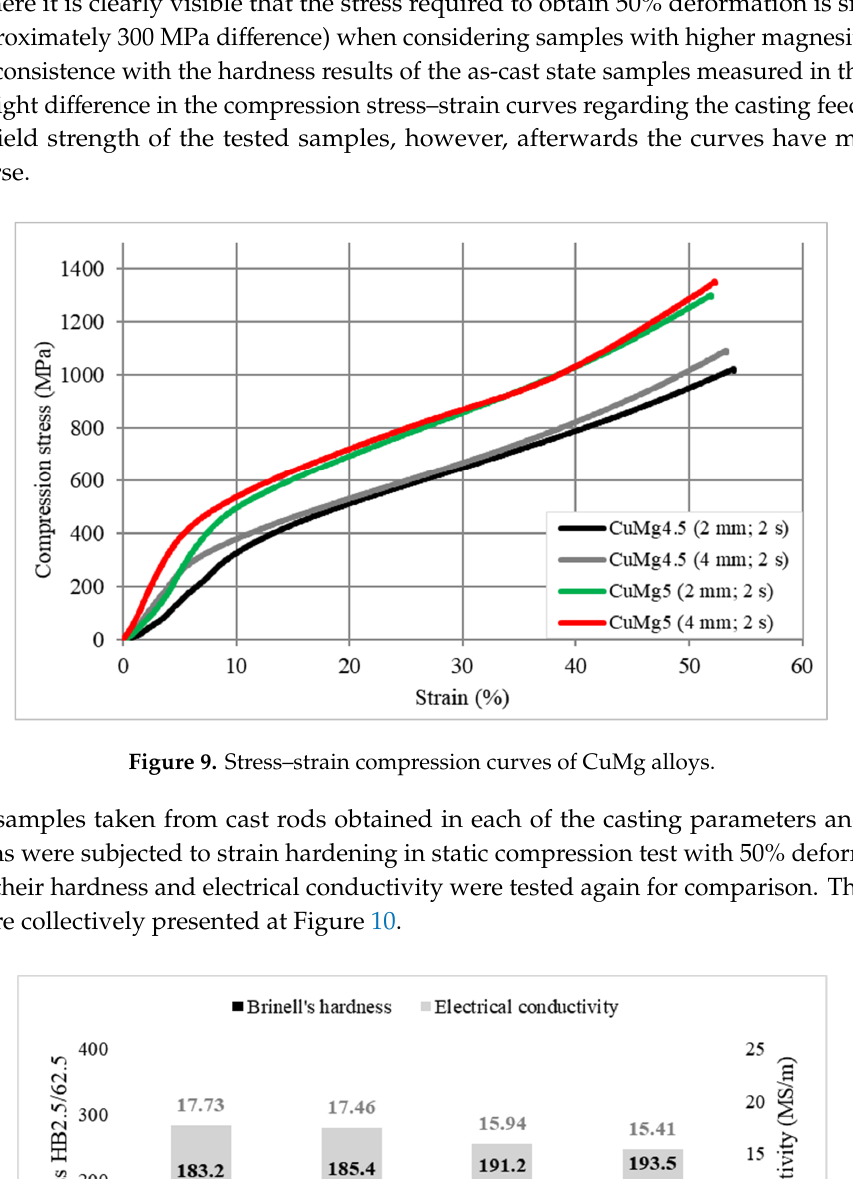
Figure 9. Stress–strain compression curves of CuMg alloys.